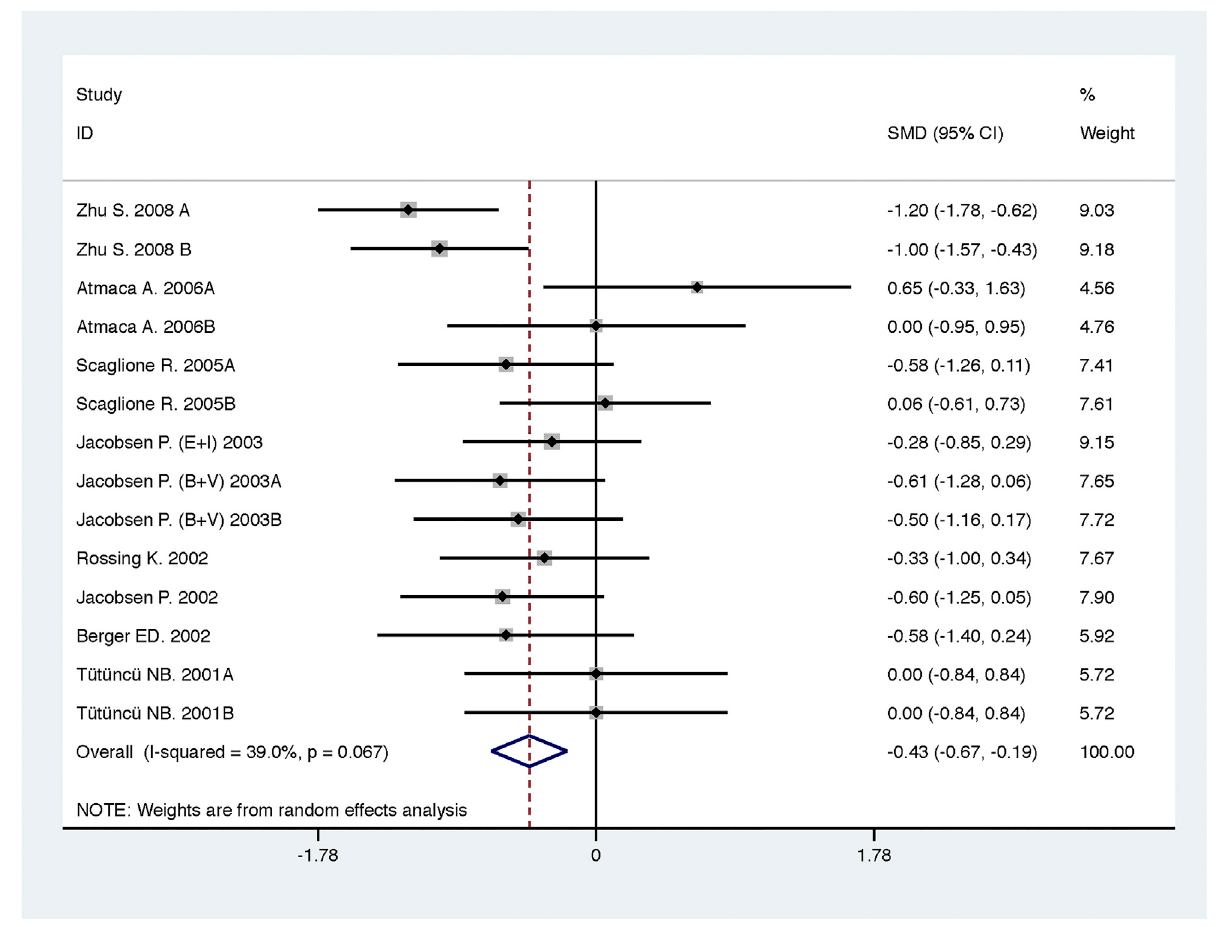
Frontiers in Pharmacology |